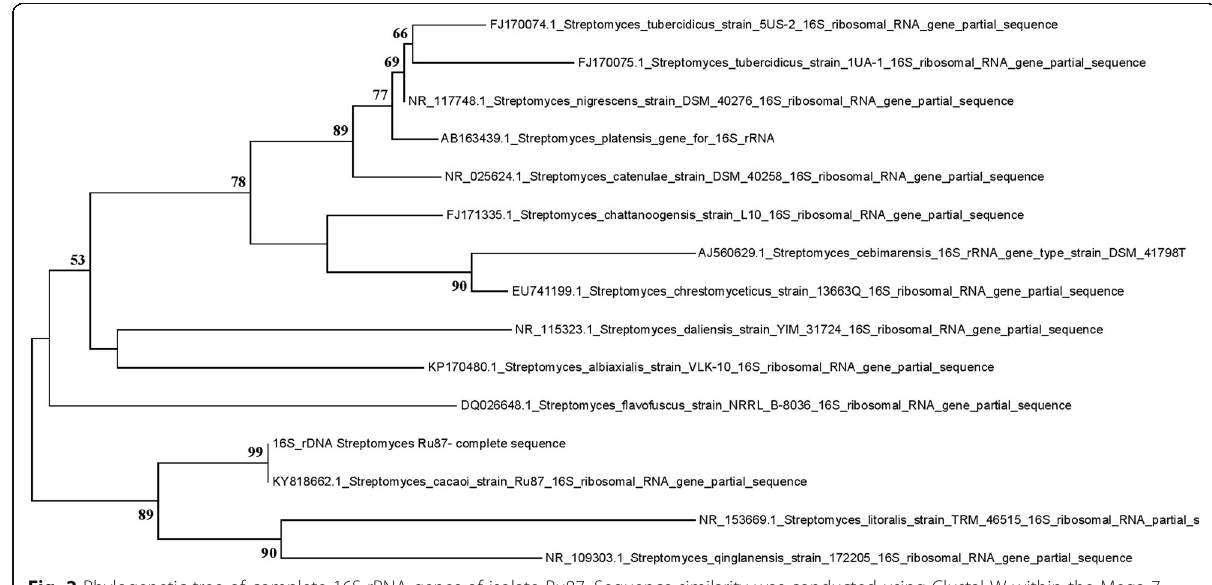
Fig. 2 Phylogenetic tree of complete 16S rRNA genes of isolate Ru87. Sequence similarity was conducted using Clustal W within the Mega 7 program. Phylogenetic trees were constructed using the Neighbor-Joining